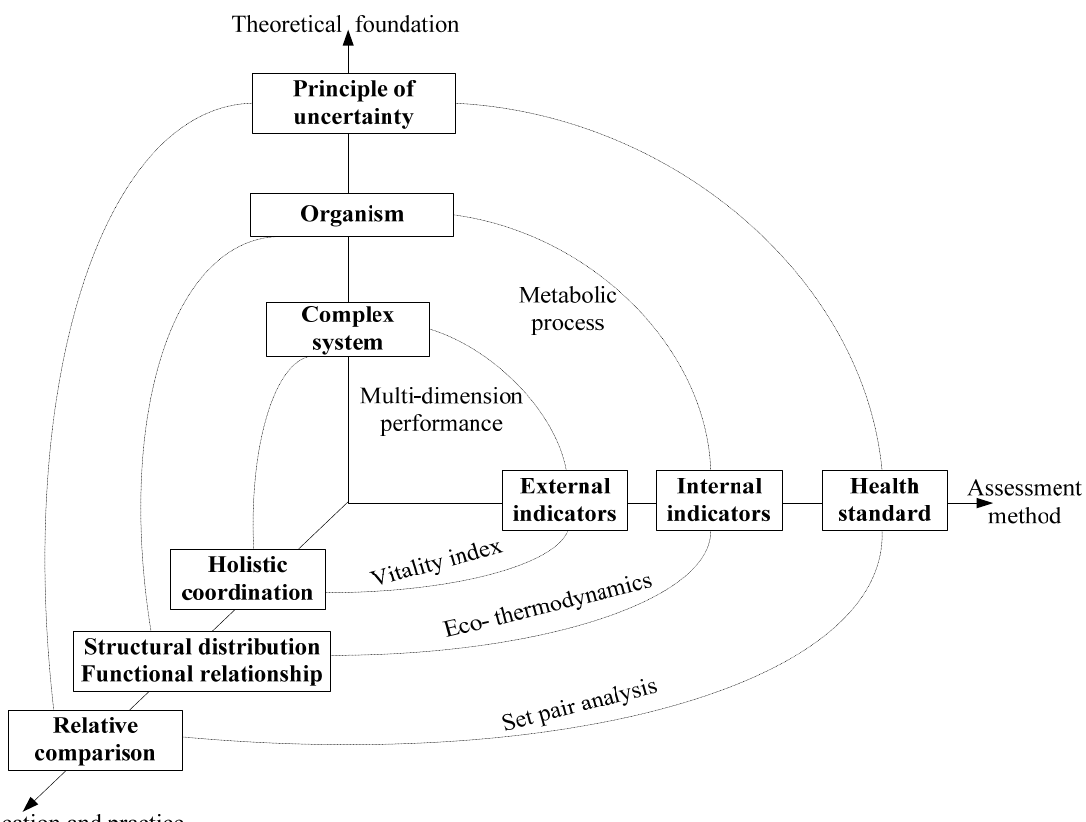
Figure 1. Fundamental framework of urban ecosystem health